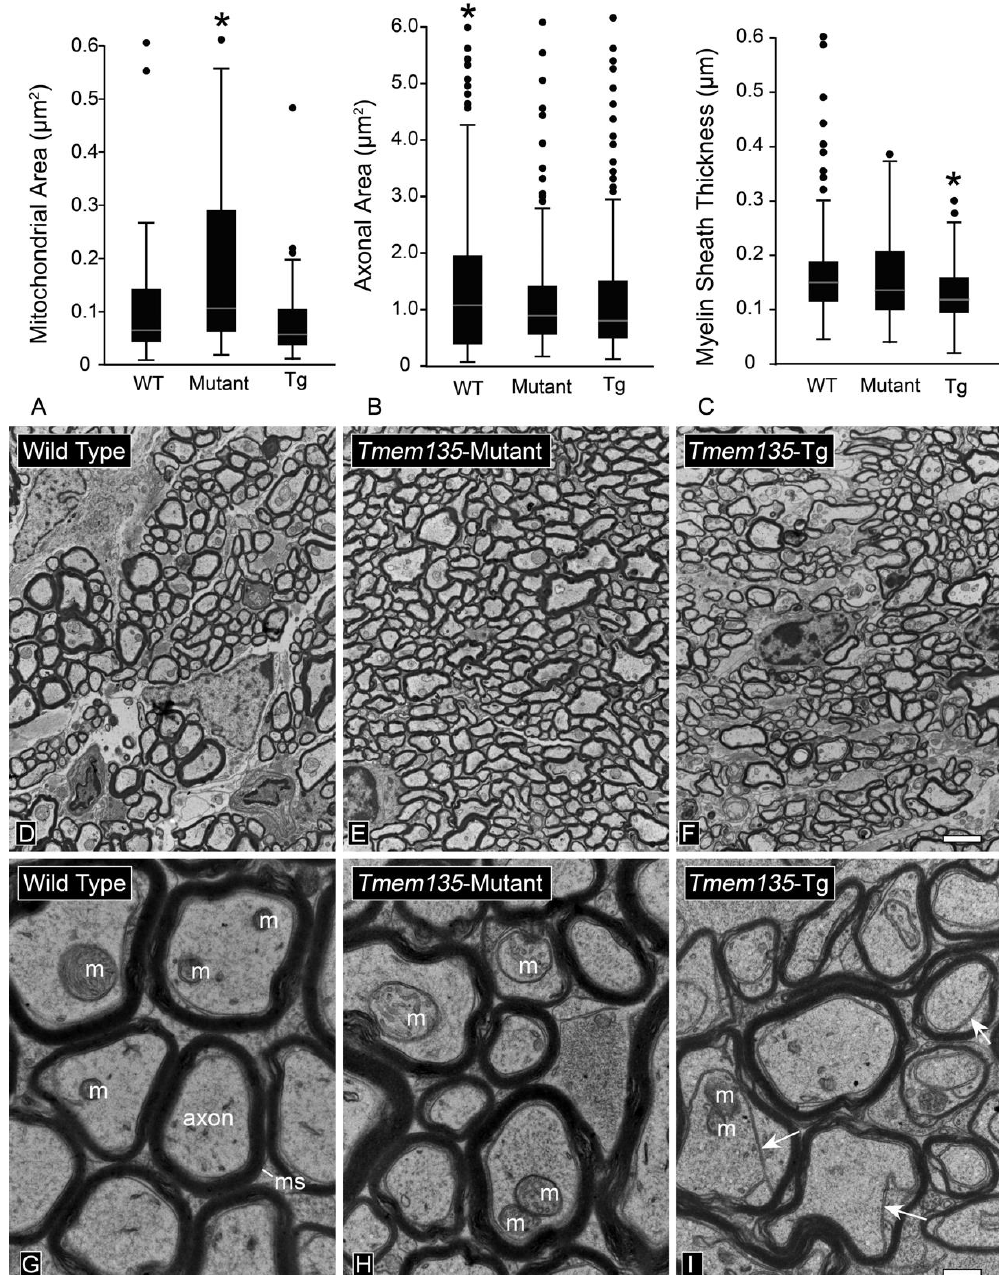
Figure 7. Examination of the optic nerves and RGC mitochondria in mice after modulation of Tmem135 expression. TMEM135 plays a role in mediating mitochondrial fission [162]. To examine the effect of modulating expression of Tmem135 , we compared the optic nerves of wild type (WT), Tmem135 mutant, and Tmem135 over-expressing ( Tmem135-Tg ) mice at seven months of age using transmission electron microscopy (see supplemental methods). ( A ) Box-and-whisker plots (plotted outliers represent values outside the ninetieth percentile) of mitochondrial area inside axons. Mutant mice exhibited significantly larger mitochondria in RGCs, consistent with a defect in mitochondrial fission in these animals (* p < 0.0001, relative to both other genotypes). Transgenic mice exhibited slightly smaller mitochondria than WT mice, but this was not significant. ( B ) Axon areas are larger in WT mice compared to both other groups (* p < 0.009). ( C ) Transgenic mice exhibited thinner myelin sheaths than the other two groups of mice (* p < 0.0001). ( D – F ) Low power representative images of axons in WT, mutant, and transgenic mice, respectively. Scale bar = 2 µ m. ( G – I ) High magnification images of axons in each group. Mitochondria (m) and myelin sheaths (ms) are indicated. Arrows in ( I ) indicate the membranes of axons that have separated from the myelin sheath in the Tmem135 overexpressing mice. Scale bar = 500